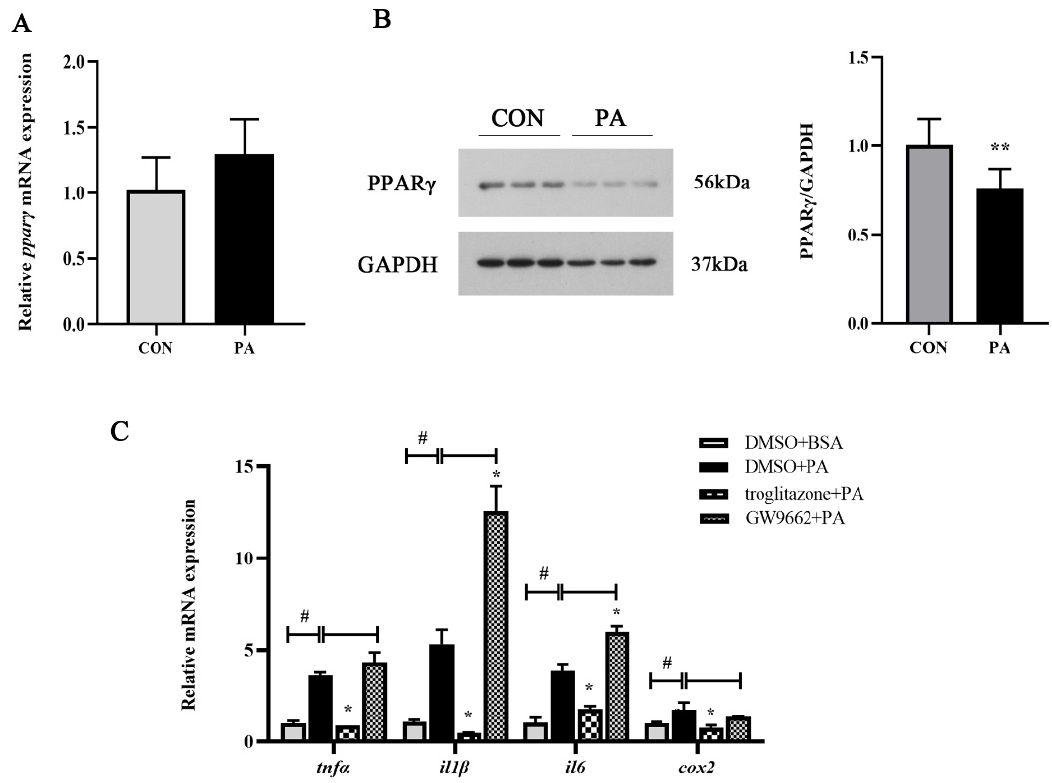
Figure 5. PPAR γ was involved in PA-induced inflammation. ( A , B ) mRNA and protein expression levels of PPAR γ after PA treatment ( n = 6). The ratio of PPAR γ to GAPDH was determined. ( C ) Effects of the PPAR γ activator (troglitazone) and inhibitor (GW9662) on the mRNA expression levels of the inflammatory genes induced by PA ( n = 3). Data are presented as the means ± SEM and analyzed using independent t -tests. # p < 0.05 indicates significant differences compared with the BSA group as the negative control. * p < 0.05 and ** p < 0.01 indicate significant differences compared with the control group.